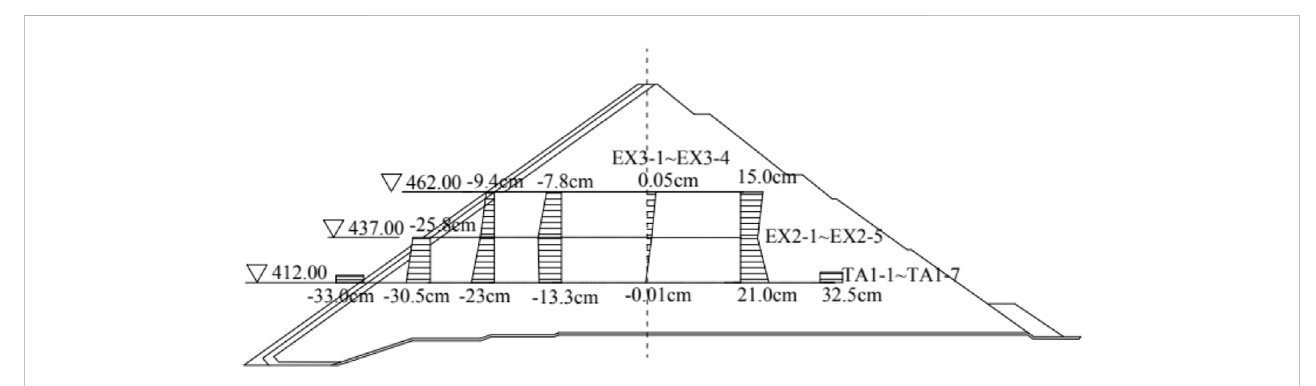
FIGURE 6 Horizontal deformation of dam In March 2014.